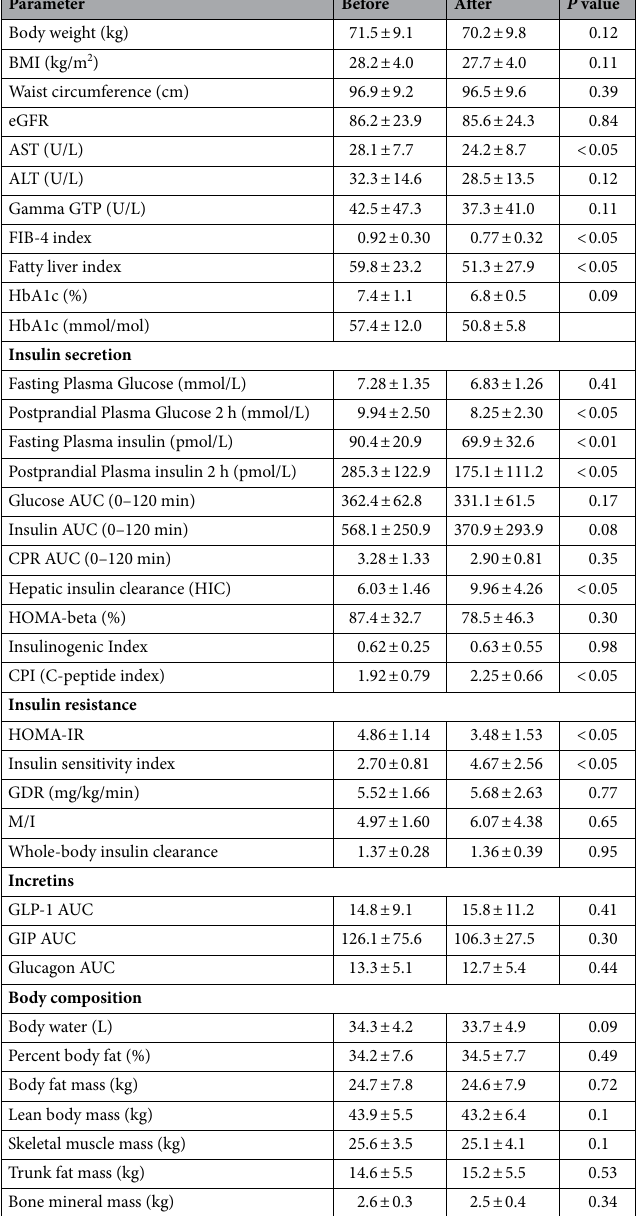
Table 1. Comparison between before and after SGLT2 treatment. Data are presented as the mean ± standard deviation values. The comparison of parameters before and after treatment was performed using the Mann–Whitney U test. The chi-square test was used for categorical comparisons of sex data. ALT alanine aminotransferase, AST aspartate aminotransferase, AUC area under the curve, BMI body mass index,